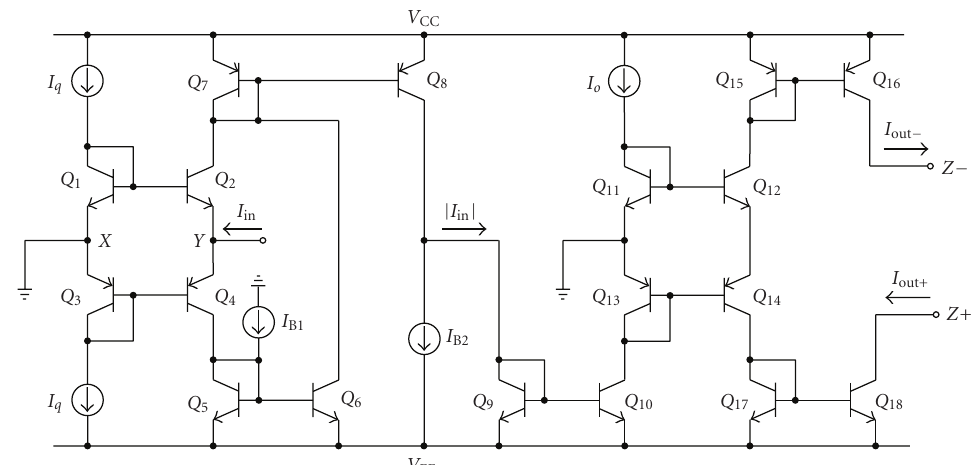
Figure 3: Proposed dual-output current-mode square-rooting circuit.